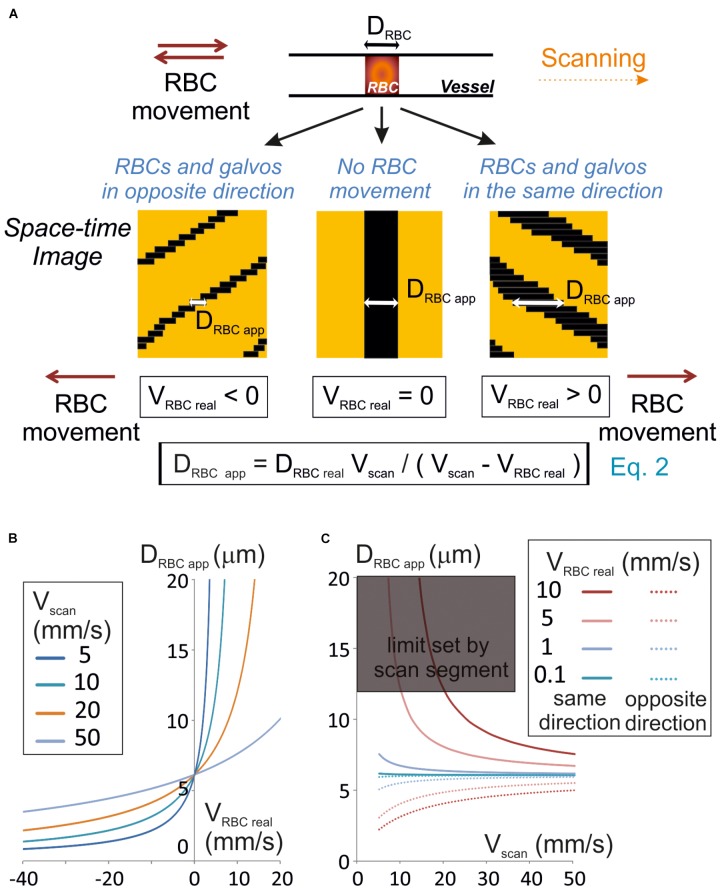
Unbiased measurement of RBCs size. (A) RBC apparent size (DRBCapp), depends on the scanning velocity (Vscan) and direction. Scanning can be performed along or opposite to the RBC displacement (anterograde or retrograde scanning, respectively). Left panel: retrograde scanning; center panel: in the absence of RBC movement; right panel: anterograde scanning. A unique equation (Eq. 2) describes the relationship between DRBCapp, the real size of the RBC (DRBCreal), Vscan and the real velocity of the RBC (VRBCreal). (B) Anterograde scanning overestimates the RBC size whereas retrograde scanning underestimates the RBC size. The theoretical apparent size of a RBC (real size set to 6 μm diameter) was calculated from Eq. 2 and plot versus VRBCreal for a range of Vscan typically used in standard two-photon microscopes. (C) Retrograde scanning allows accessing a larger range of RBC velocities. The theoretical apparent size of a RBC (real size set to 6 μm diameter) was calculated from Eq. 2 and plot versus Vscan for a range of VRBCreal. As the scan length sets a limit to DRBCapp, the range of scanning velocities that can be used to measure a given VRBC covers a limited range of Vscan if scanning is performed in the same direction as blood flow, but the whole range of scanning speeds can be used if scanning is performed opposite to blood flow. The range of scanning velocities that can be used is further limited by the length of the scanned segment.